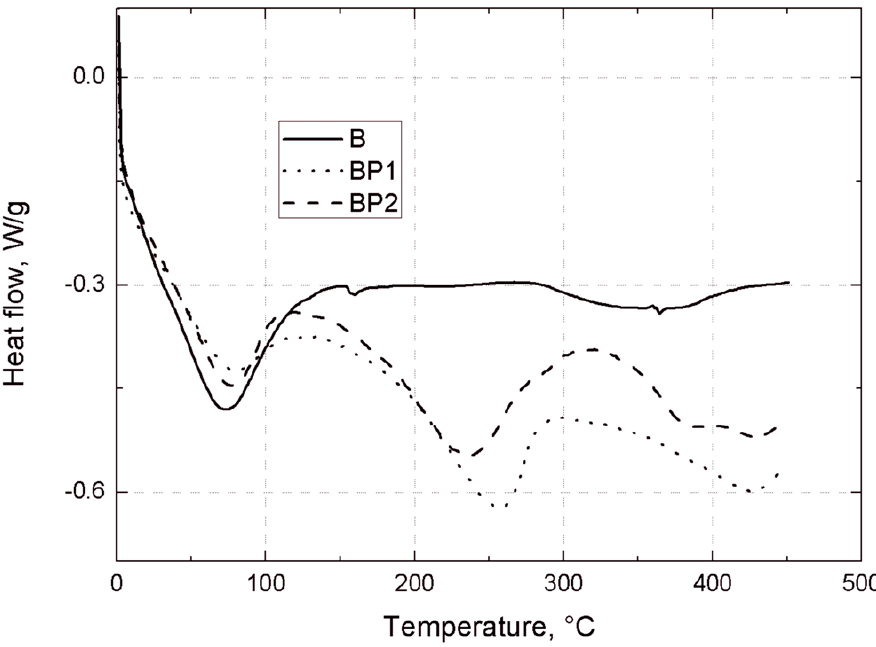
1. DSC curves of the examined bentonites: unmodified bentonite